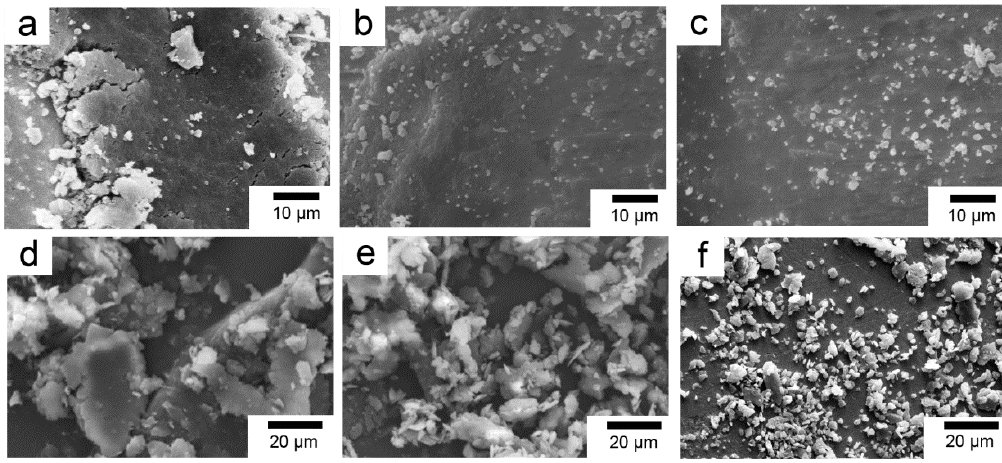
Figure 14. SEM photographs of the counterface and wear debris corresponding to the ( a , d ) PBO- Pre/PI, ( b , e ) PBO-APTES/PI, and ( c , f ) PBO-La/PI